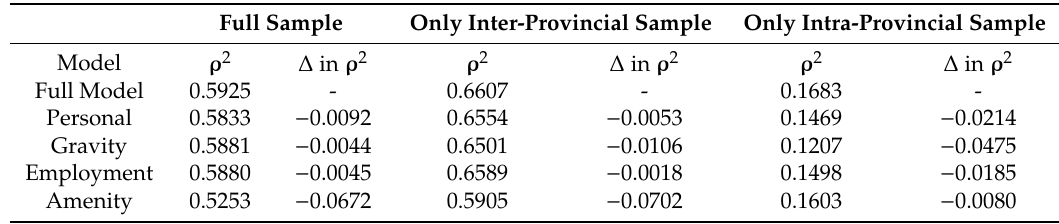
Table 5. Change in ρ 2 for di ff erent model specifications and